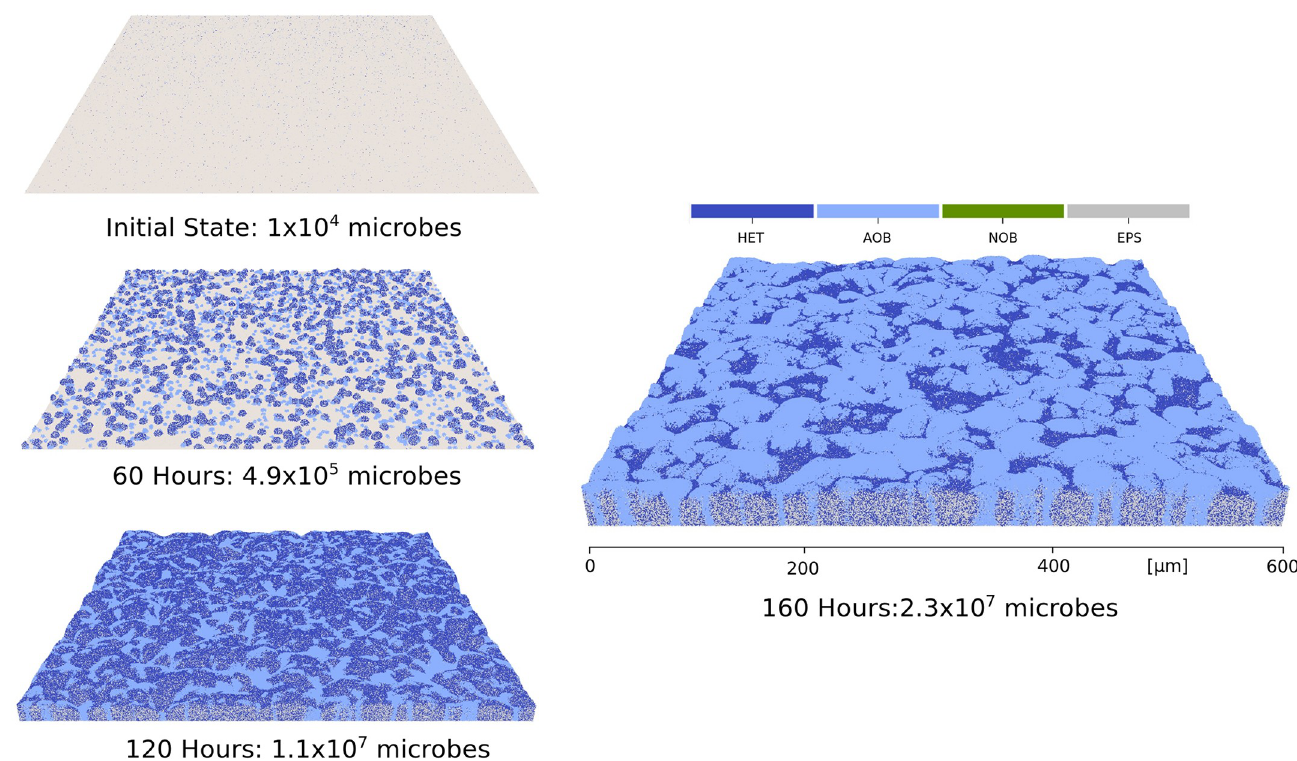
Fig 6. Biofilm development after 0, 60, 120, and 160 hours. The simulation uses 100 processors and 30 hours CPU time to reach 2.3 × 10 7 particles. The biological timestep is 0.25 hour. Particle colours are blue for heterotrophs, grey for EPS, light blue for AOB, and green for NOB.